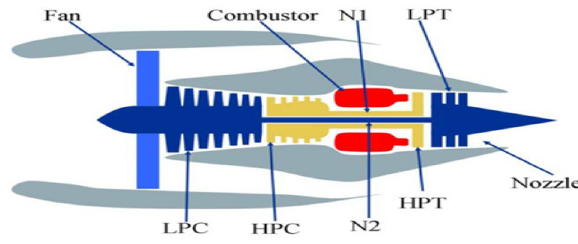
Figure 4. The turbofan engine model.